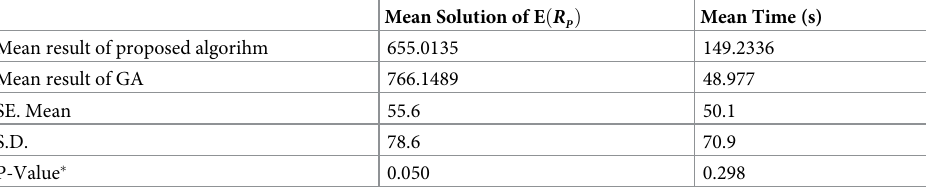
Table 6. The average results of solving GA and proposed algorithm and comparing them with each